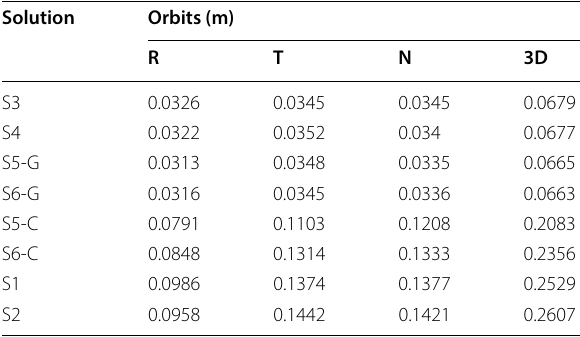
Table 3 OBD of BDS-3 and GPS